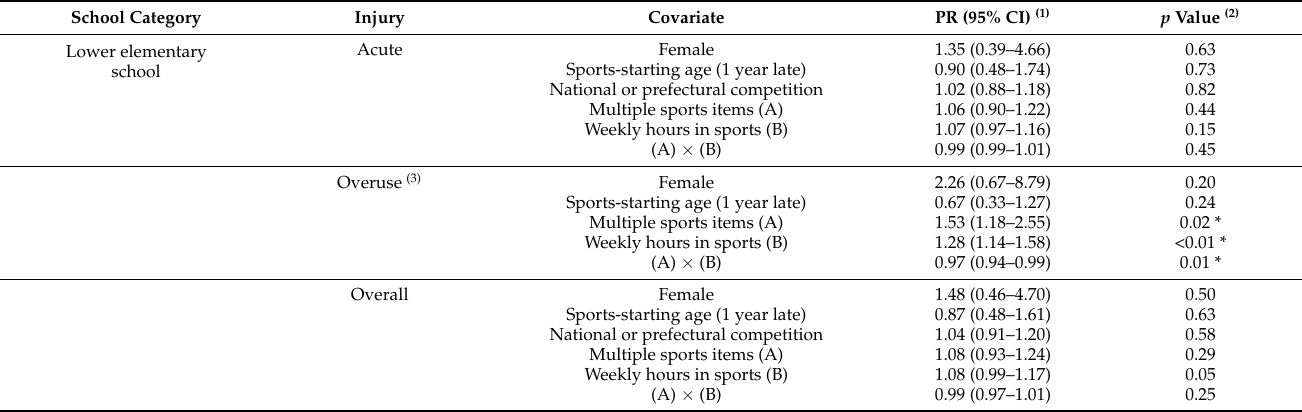
Table 5. Adjusted prevalence ratio with 95% confidential interval of sports-related injuries according to school categories using multiple